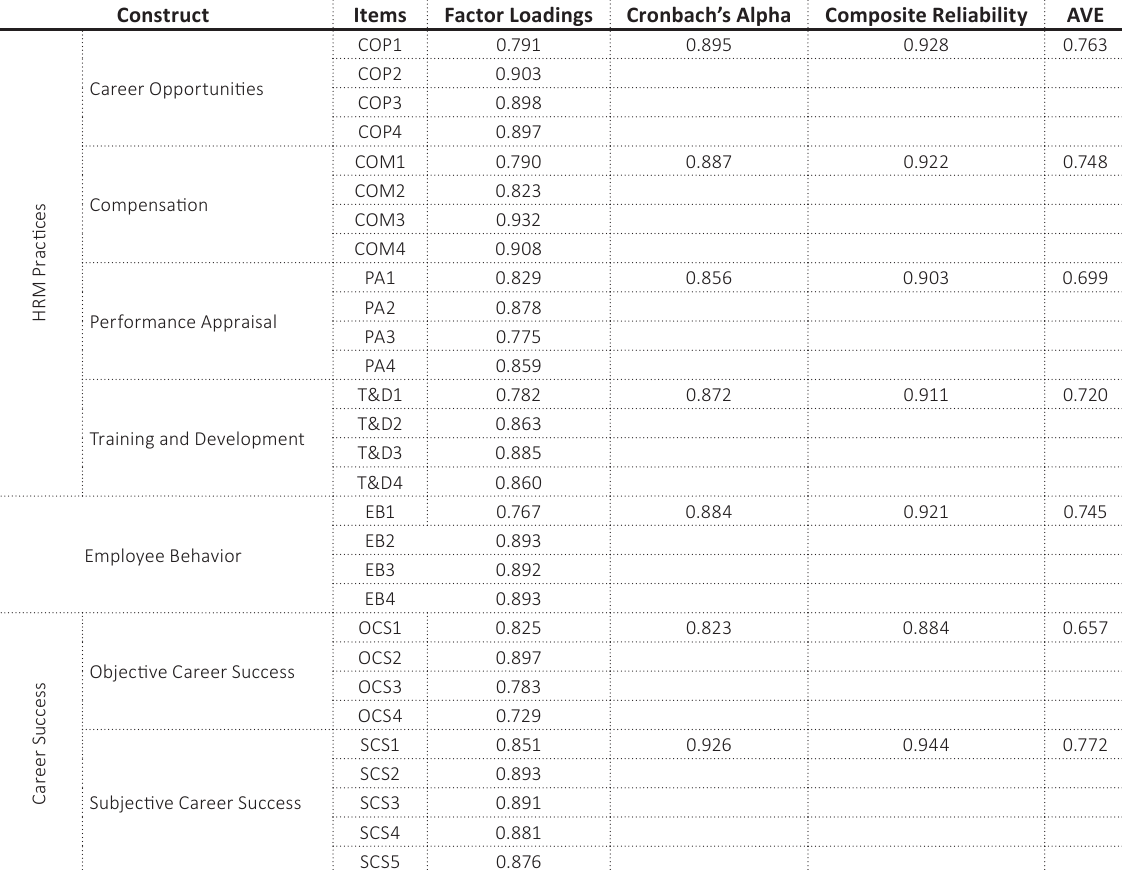
Table 3. Consistency reliability and convergent